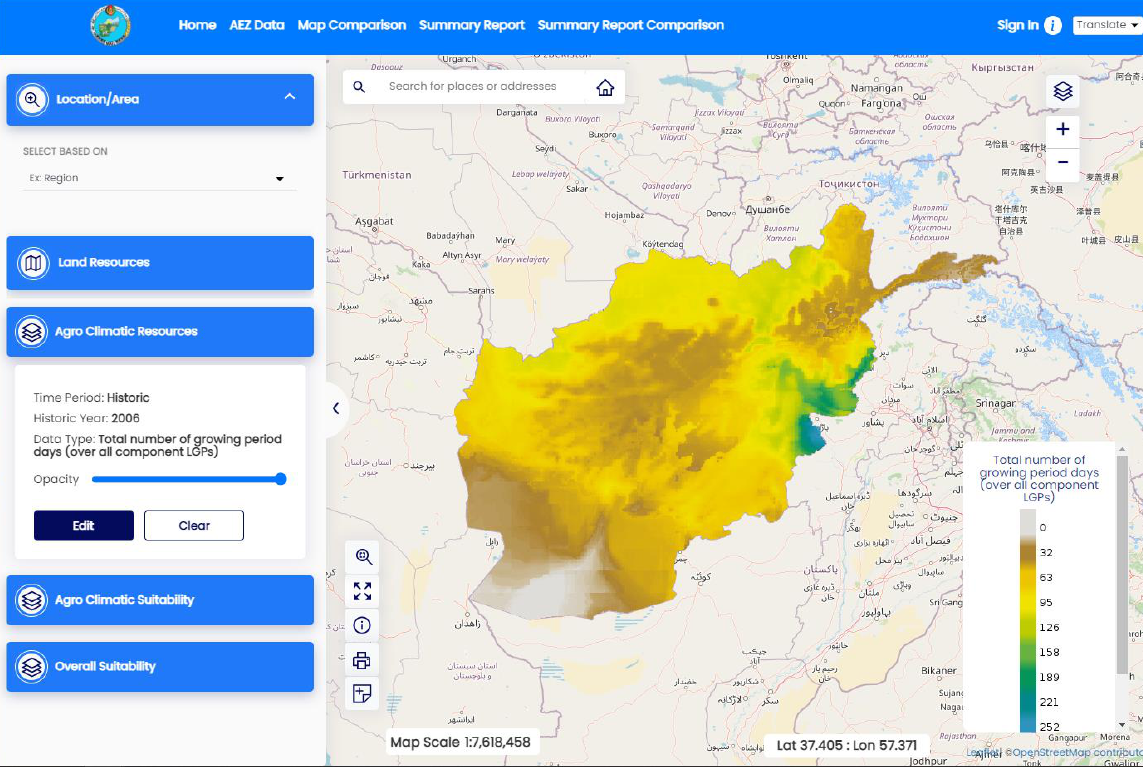
Figure 4. Interface of the web-GIS portal of LRIMS